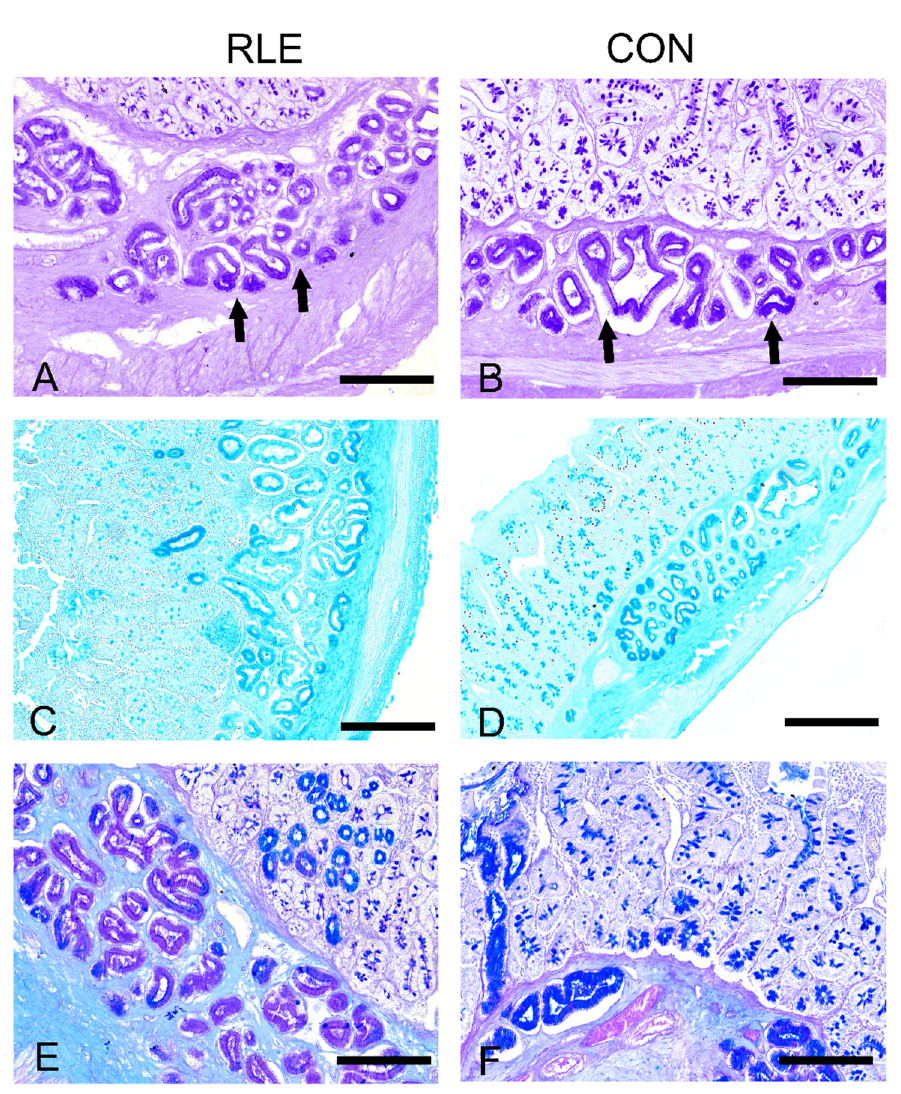
Figure 1. The histochemical response of kids’ duodenum secretory structures. ( A , B ). PAS (periodic acid–Schiff) staining showing less strong staining of Brunner’s glands in Group CON compared to Group RLE. Arrows indicate Brunner glands. ( C , D ). Alcian blue staining (pH 2.5) displaying a weaker histochemical response in goblet cells and Brunner’s glands of the control group compared to Group RLE. ( E , F ). Alcian-PAS staining depicting much less intense Alcian blue staining in the globet cells and Brunner’s glands of CON animals compared to RLE animals. Scale bars: ( A , B , E , F ) =100 µ m; ( C , D ) = 50 µ